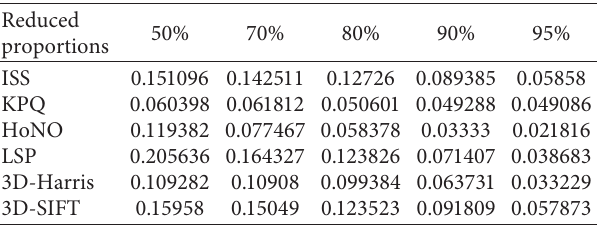
Table 9: The resolution repetition rate r detection algorithm on the Kinect data set.